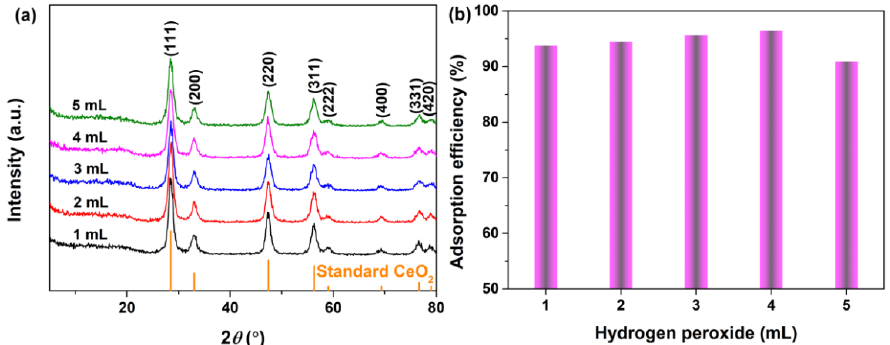
Figure 3. ( a ) XRD patterns of CeO 2 synthesized at a set hydrothermal temperature of 120~200 °C for 24 h with 4 mmol guanidine carbonate and 5 mL 30% H 2 O 2 . ( b ) Adsorption histograms of AO7 dye onto the as − obtained corresponding CeO 2 in Figure 3a ([CeO 2 ] = 2.0 g/L; [AO7] = 100 mg/L; V = 100 mL; 200 rpm; Room temperature; No pH preadjustment; t = 60 min).